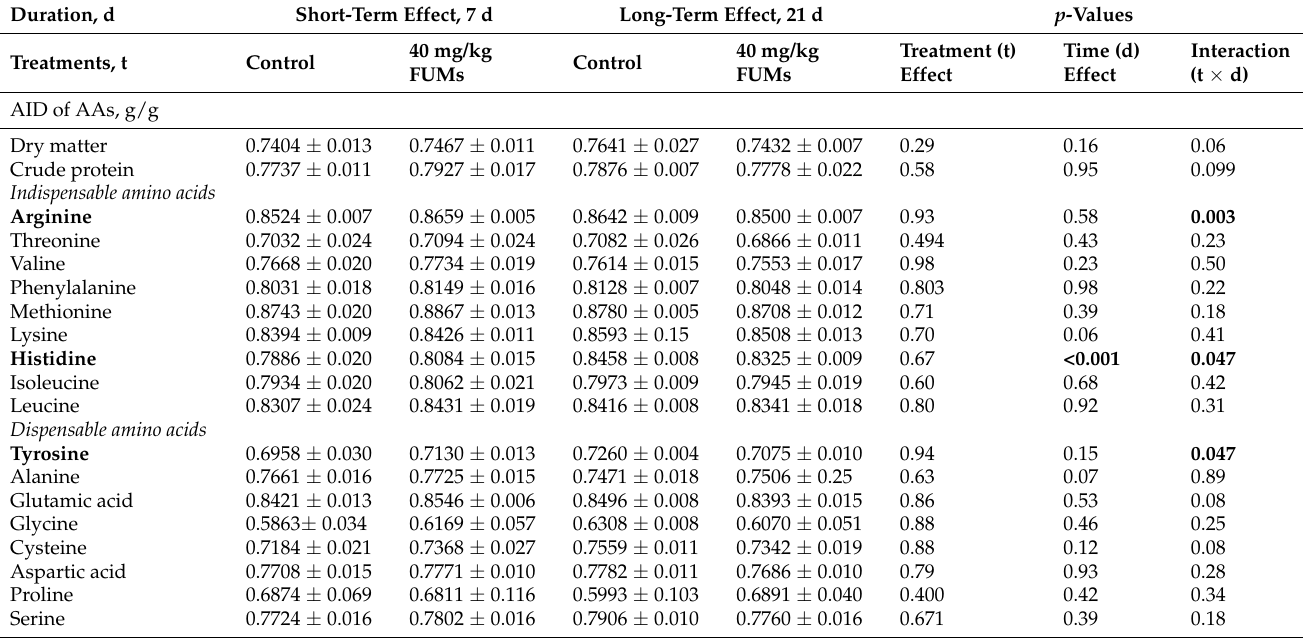
Table 5. Effect of short (7 d)- or long (21 d)-term exposure of dietary fumonisins on apparent ileal digestibility of dry matter, crude protein, and amino acids in fattening pigs (data are means ± standard deviation (SD) of 5